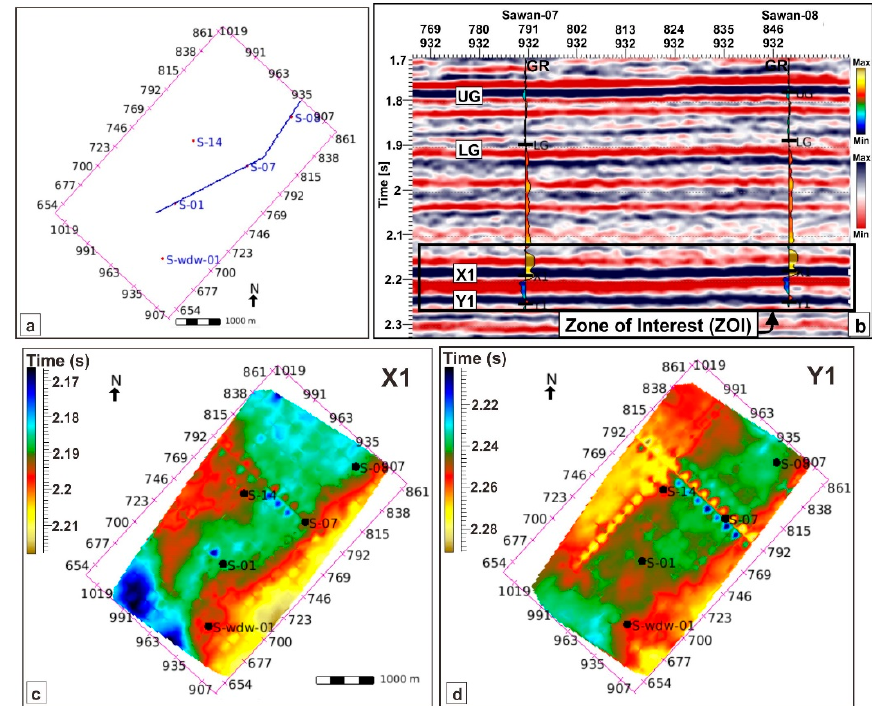
Figure 3. ( a ) Basemap of the study area. The arbitrary line is selected that is passing through S-01, S-07, and S-08 wells, which were used for inversion analysis. ( b ) Seismic-to-well-tie of S-07 and S-08 at crossline-932. The black rectangle highlights the targeted area. ( c ) Interpolation of the X1 (C-sand) horizon. ( d ) Interpolation of the Y1 (B-sand) horizon.